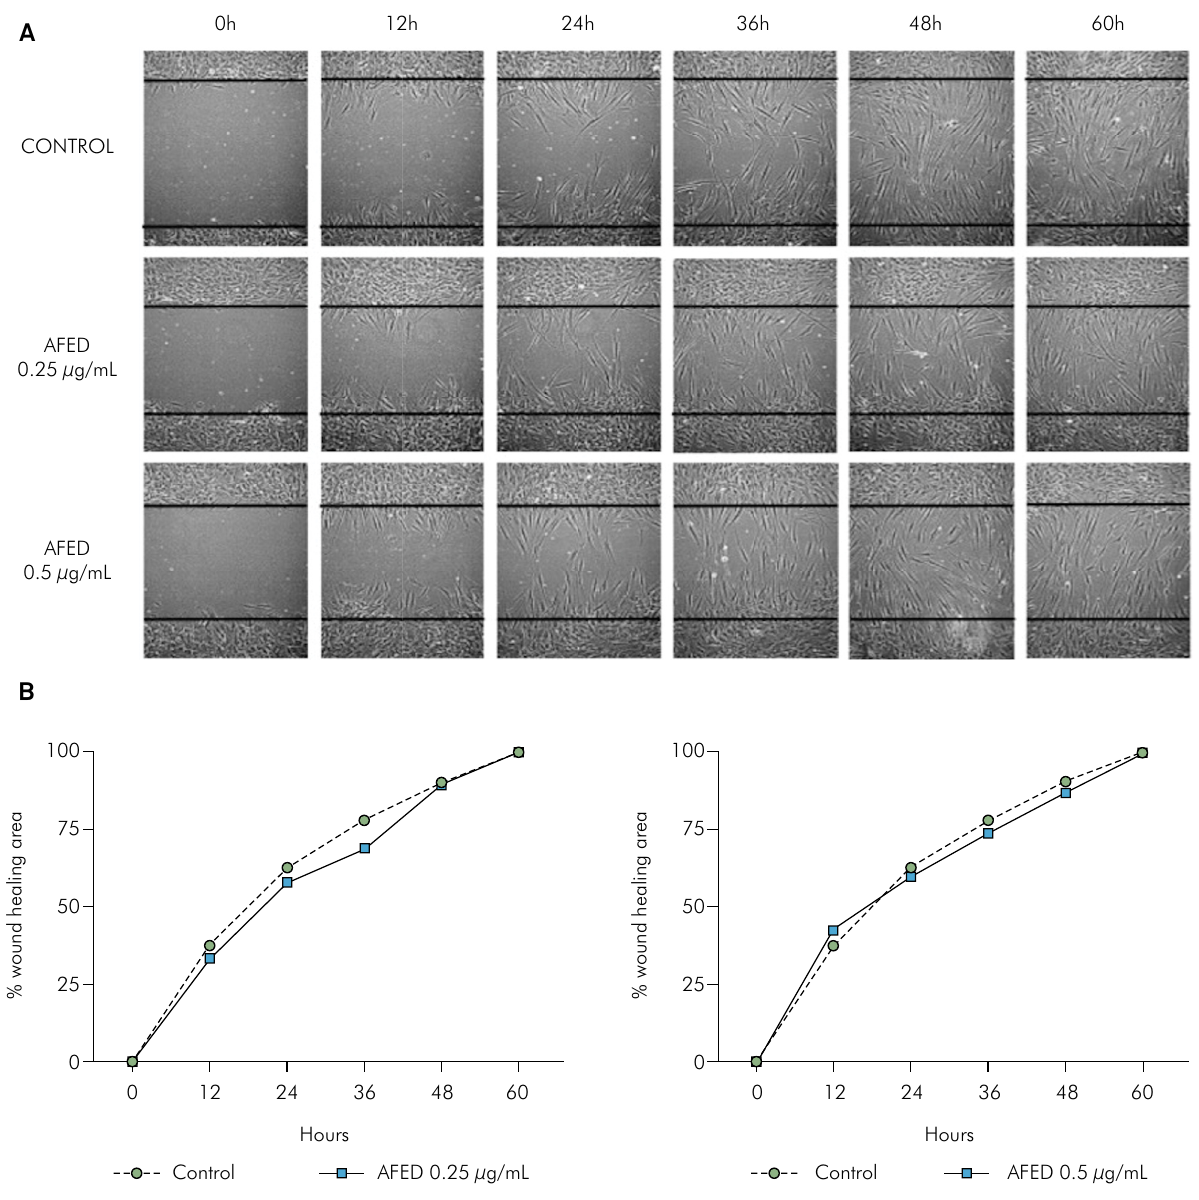
Figure 2. Wound healing assay on gingival fibroblast cells (GFC) treated and not treated with acetone fraction of Eugenia dysenterica (AFED). Cell migration was monitored using a Zeiss Microscope (ERC 5s, Göttingen, Germany) and images were obtained at 0, 12, 24, 36, 48, and 60 h after the wound gap created by “scratching” of the cell monolayer (10x magnification) (A). Wound healing area measured by calculating the wound area in each period, expressed as a percentage of the initial wound area at time zero, with the extract compared to the control (B). The data present p < 0.0001 versus